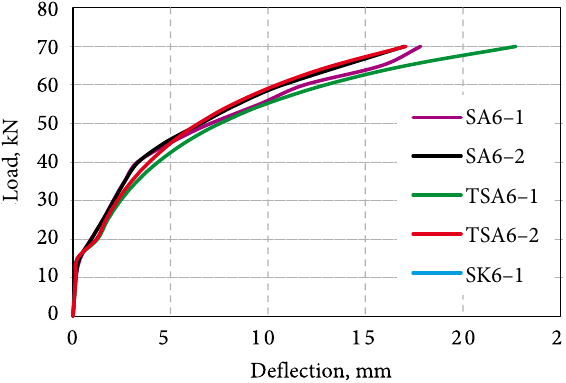
Fig. 6. Experimental (SA6) and theoretical (TSA6) deflections of beams and experimental deflection of control beam SK6–1